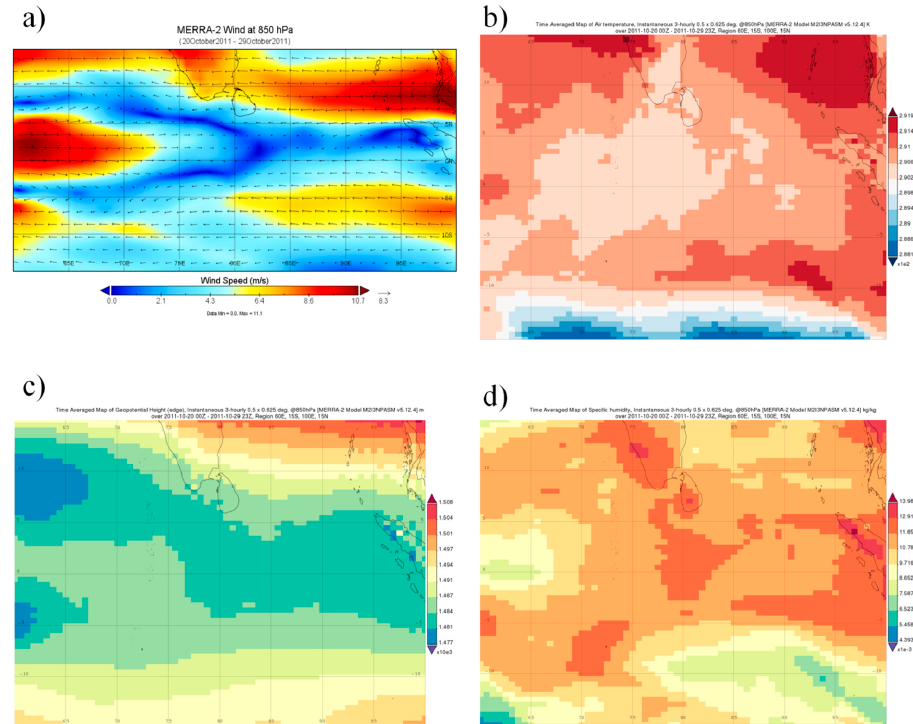
Figure 4. The average MERRA-2 atmospheric conditions at 850 hPa for the MJO event in Figure 3: ( a ) wind (in m / s); ( b ) air temperature (in Kelvin); ( c ) geopotential height (in m); and ( d ) specific humidity (in kg / kg).